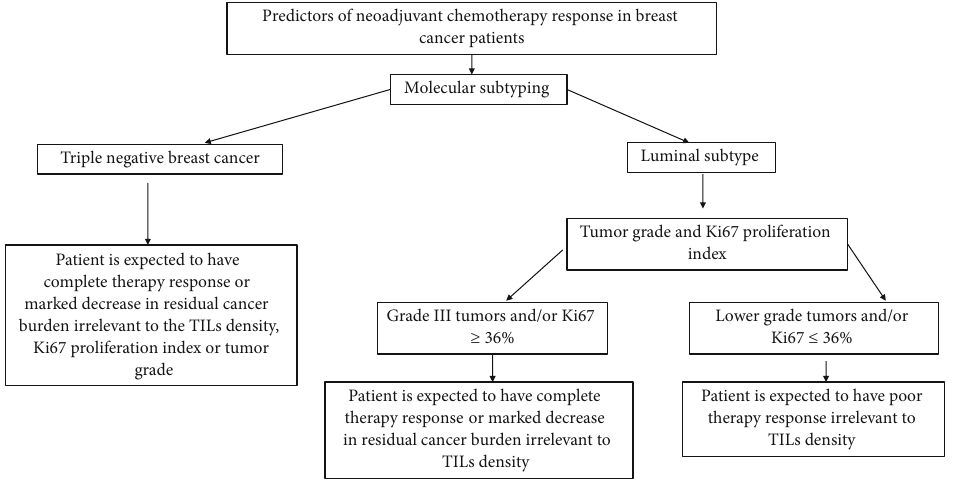
Figure 4: A guidance plan to de fi ne whether a breast cancer patient is candidate for neoadjuvant chemotherapy or